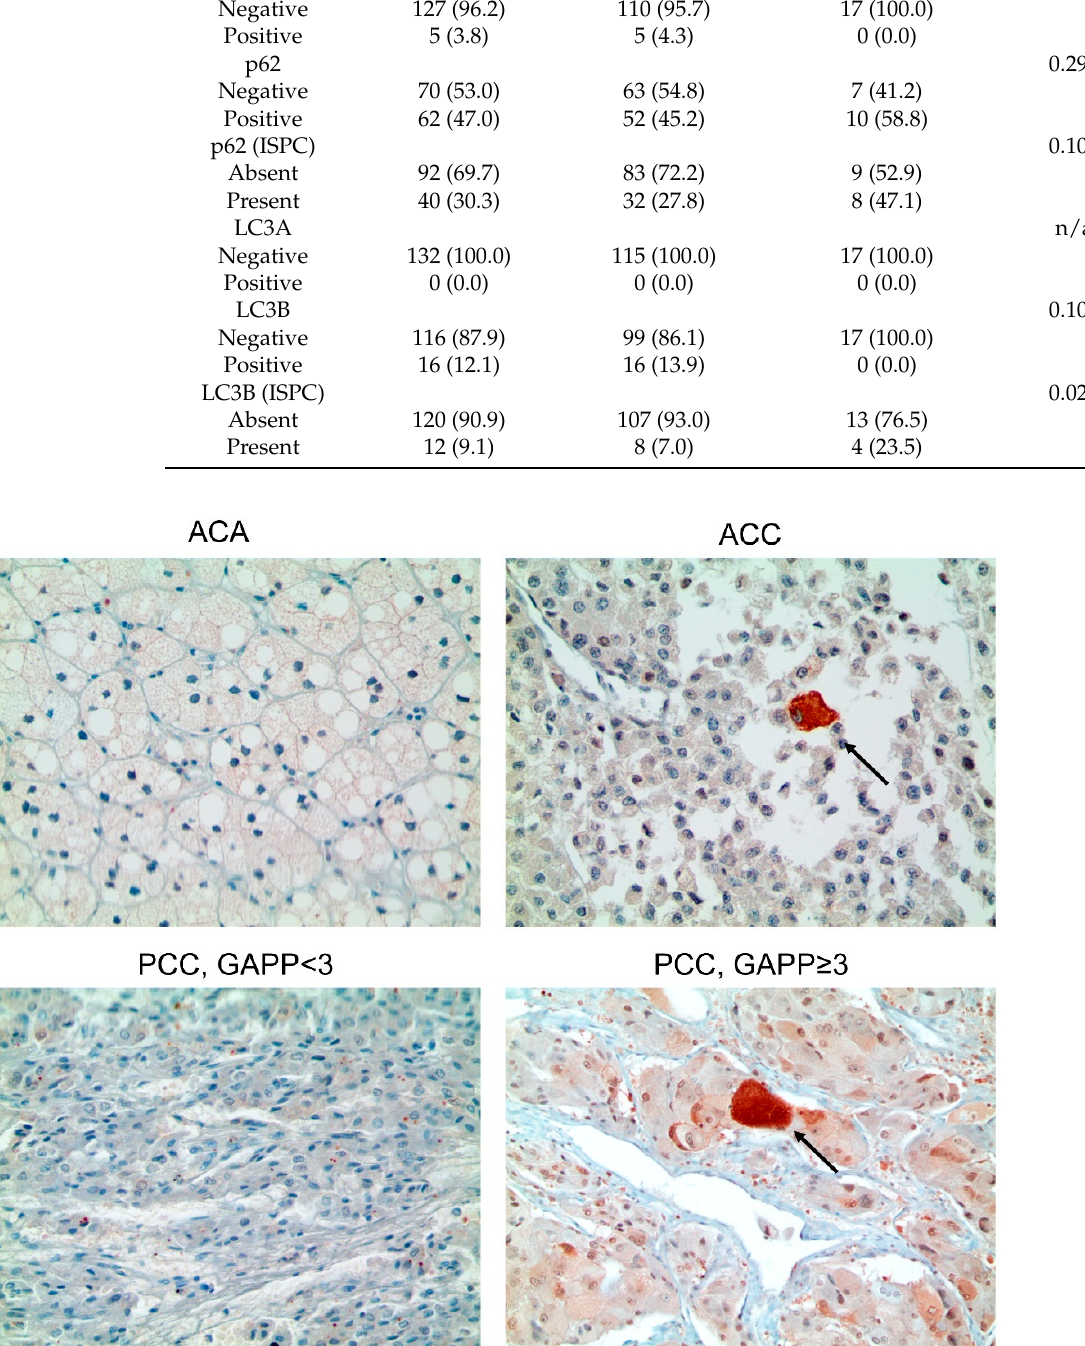
Figure 2. Isolated single positive cells (ISPC) of p62 and LC3B stain in adrenal tumors. The ISPC proportion of LC3B was higher in ACC than in ACA. The ISPC proportions of p62 and LC3B were significantly higher in PCCs with a GAPP score of ≥ 3 than in PCCs with a GAPP score of <3. Arrows indicate ISPC.